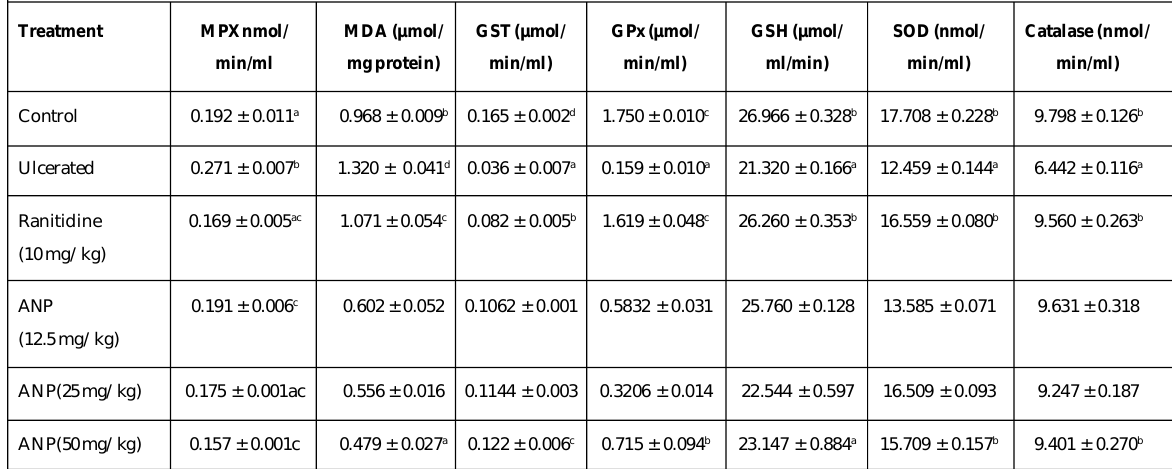
Table 4a: Effect of aqueous extract of A. nilotica seedpod on some biochemical parameters in gastric mucosa of indomethacin- Induced ulcerated rats Treatment